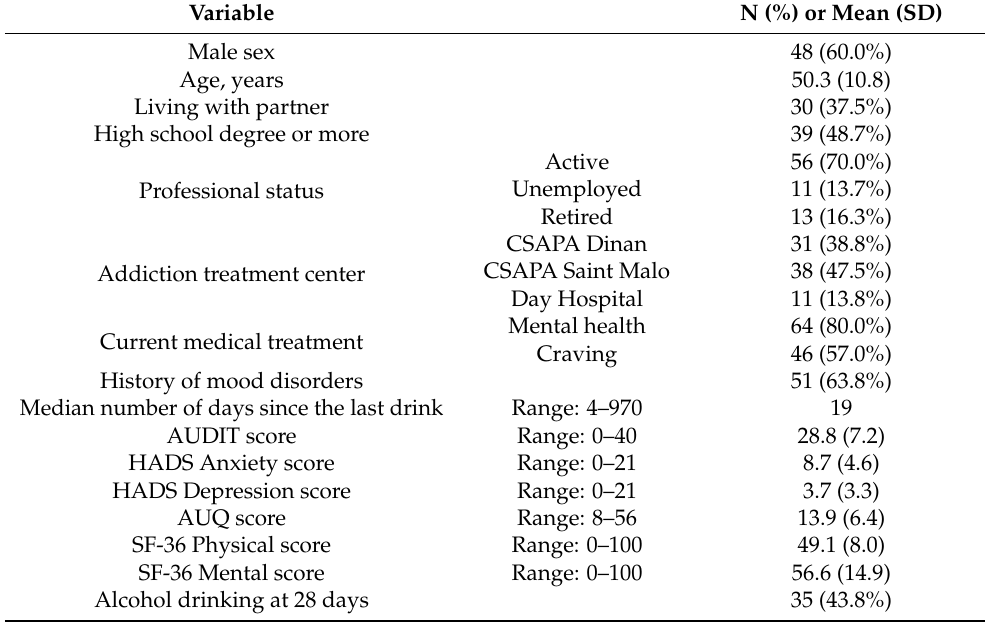
Table 1. Characteristics of participants receiving outpatient care for alcohol use disorders in the three participating addiction centers (N = 80).